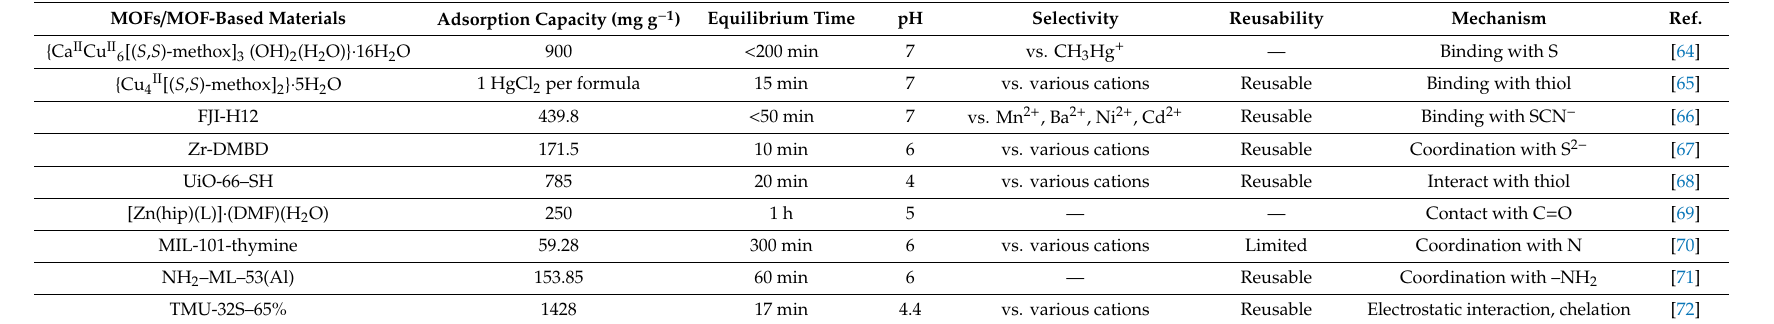
Table 3. Mercury adsorption data for the reported MOFs and MOF-based materials.